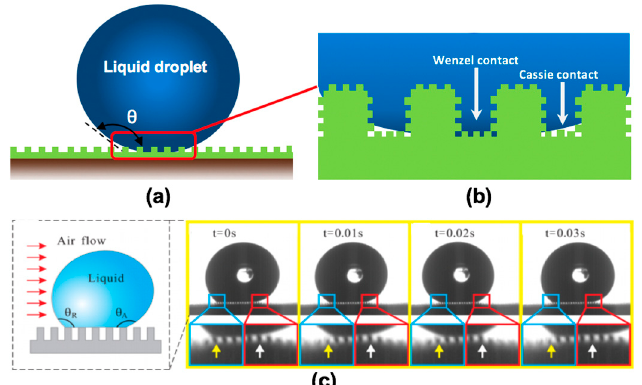
Figure 12. The movement of water on a solid gas-wetting surface: ( a ) the wetting regime of gas-wetting; ( b ) the gas-wetting model consists of the Wenzel model and the Cassie-Baxter model (reproduced with permission from [86], Copyright © 2019, American Chemical Society); ( c ) dynamic liquid on a solid surface with hydrophobicity. (Reproduced with permission from [123], Copyright © 2013, American Chemical Society).